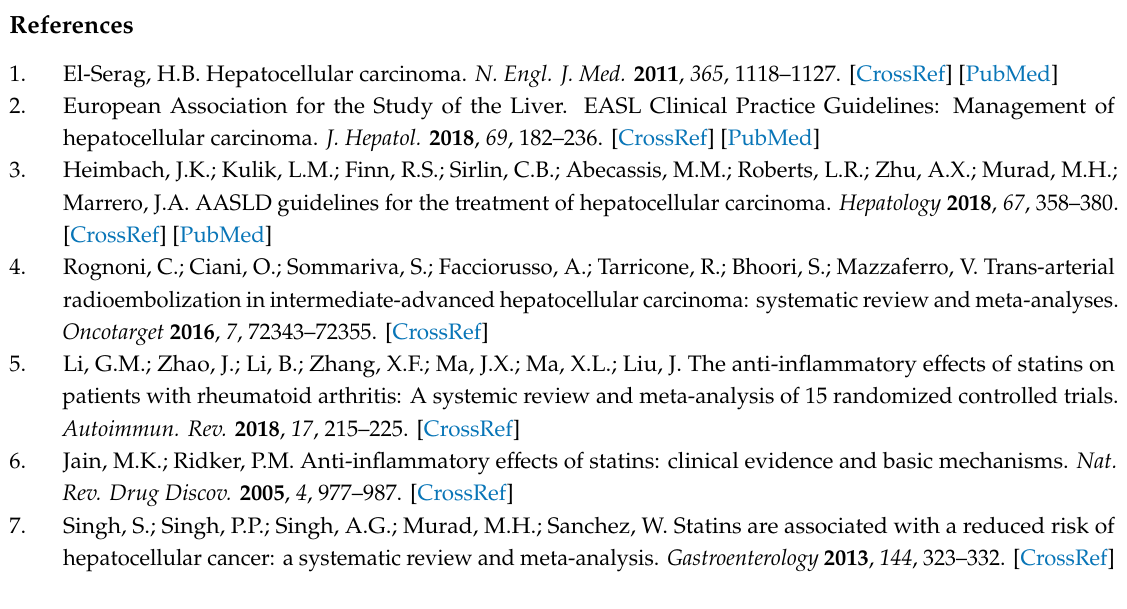
Table S1: Risk of bias assessment and quality of included